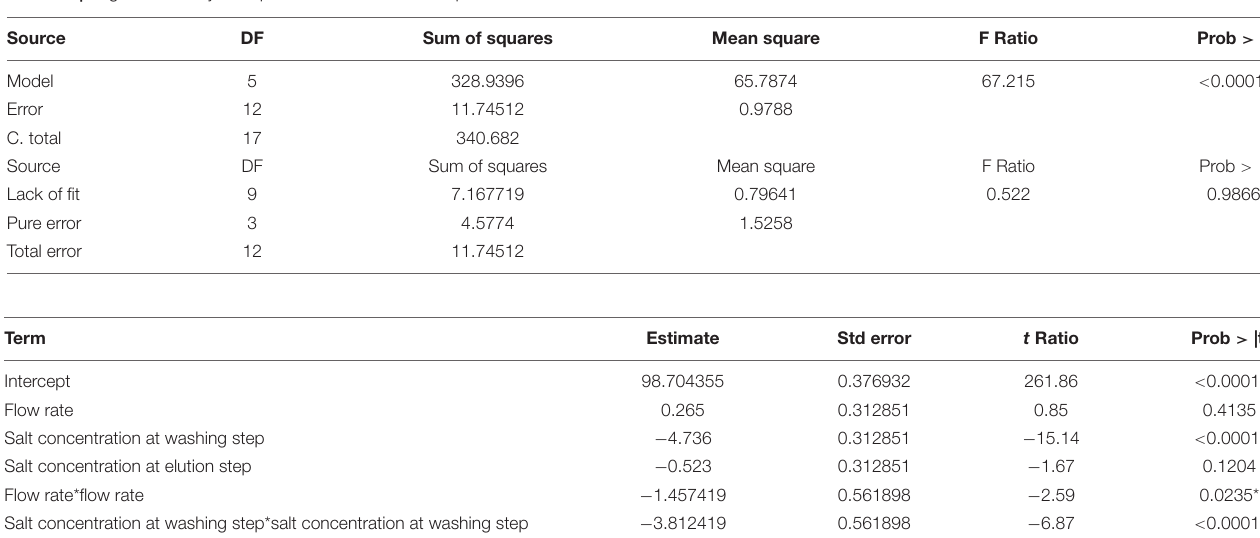
TABLE 3 | Regression analysis of predicted model for %SC